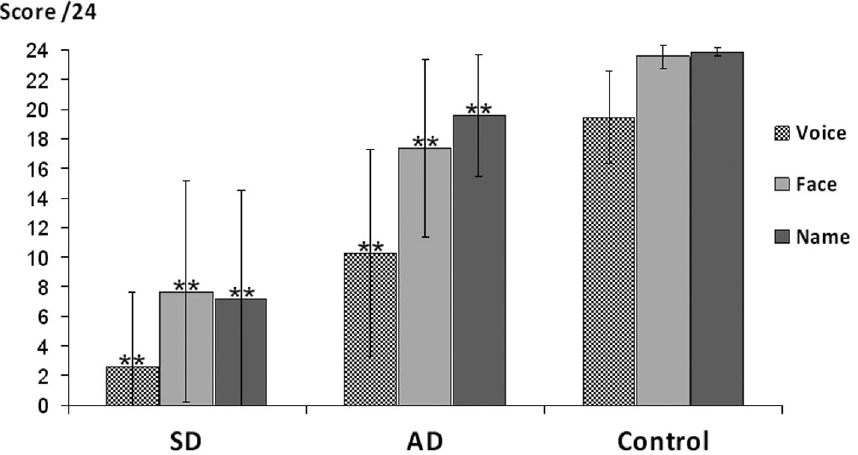
Fig. 1. Mean scores and standard deviations for voice, face and name identification tasks in SD, AD and control groups are displayed. Significant differences from controls are indicated ( p <